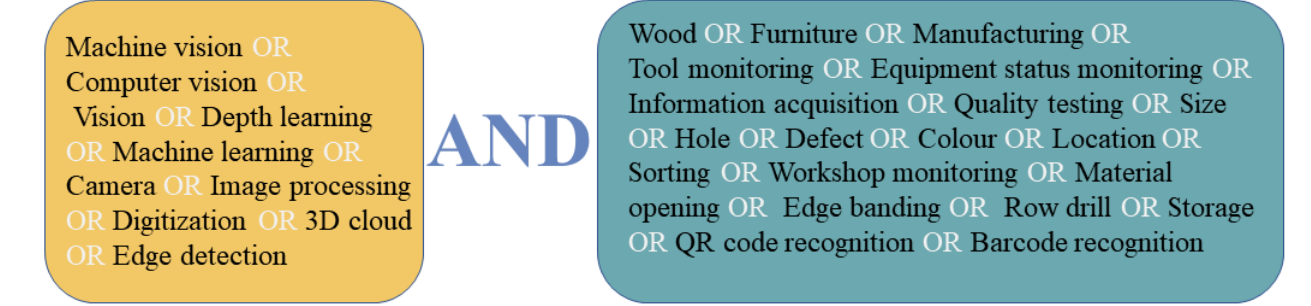
Figure 1. Keywords used for the papers collection in the selected databases. Step 3 is to select and include relevant literature. By selecting the categories of web